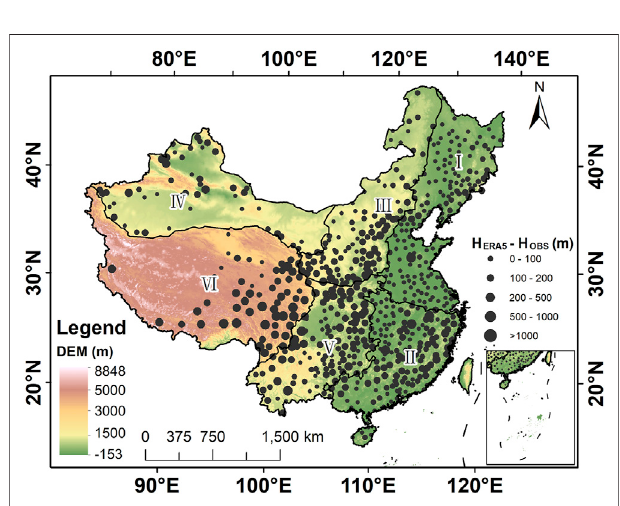
FIGURE 9 | Distribution of elevation gaps between stations and ERA5